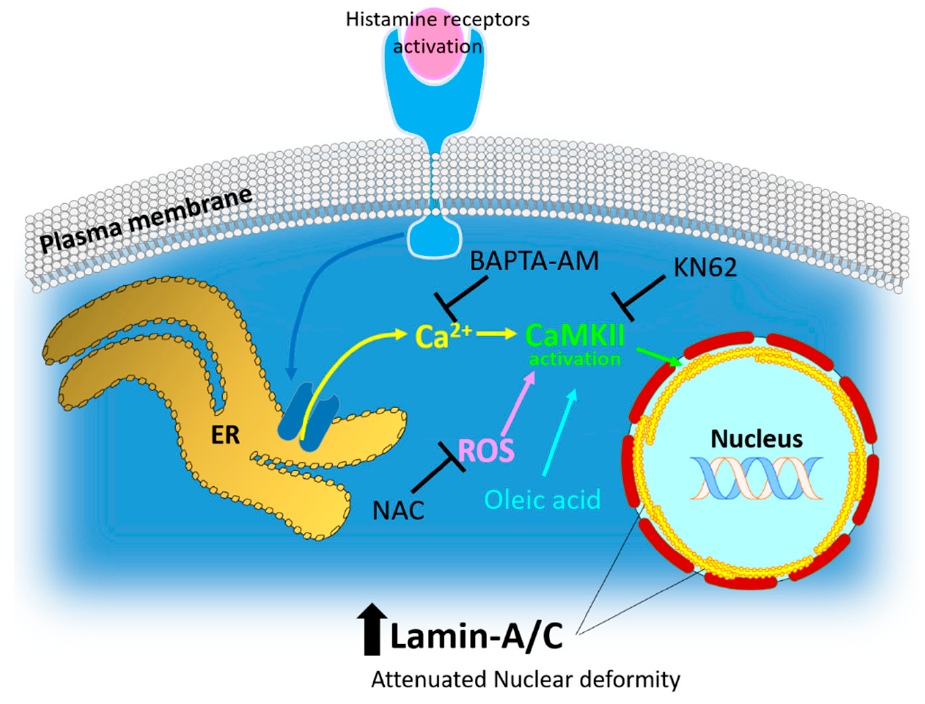
Figure 7. Schematic illustration of histamine-mediated intracellular signaling and several effectors on lamin-A/C expression. Histamine receptor activation induces calcium store ER-mediated calcium release and subsequent CaMKII activation. ROS stimulation and oleic acid treatment also induced lamin-A/C expression. Enhanced lamin-A/C expression involved attenuated nuclear deformity, suggesting the role of lamin biology on the histamine-mediated antitumor effects for the development of therapeutic targets for lung cancer. ROS: reactive oxygen species; NAC: N-acetyl-l-cysteine, ER: endoplasmic reticulum.